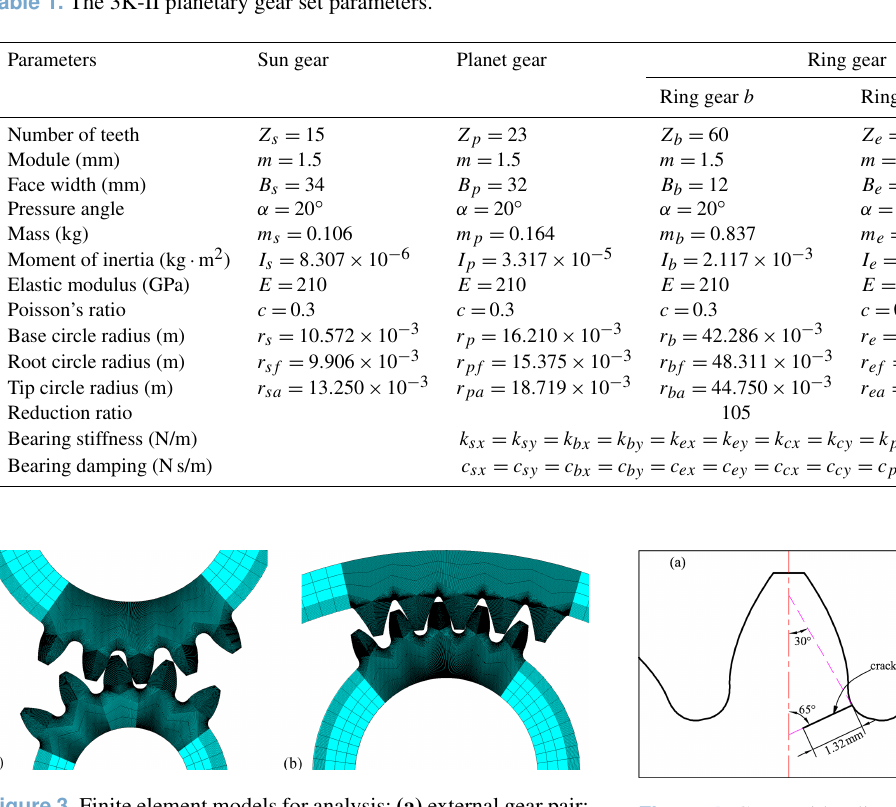
Figure 4. Gears with a linear crack: (a) external gear; (b) internal